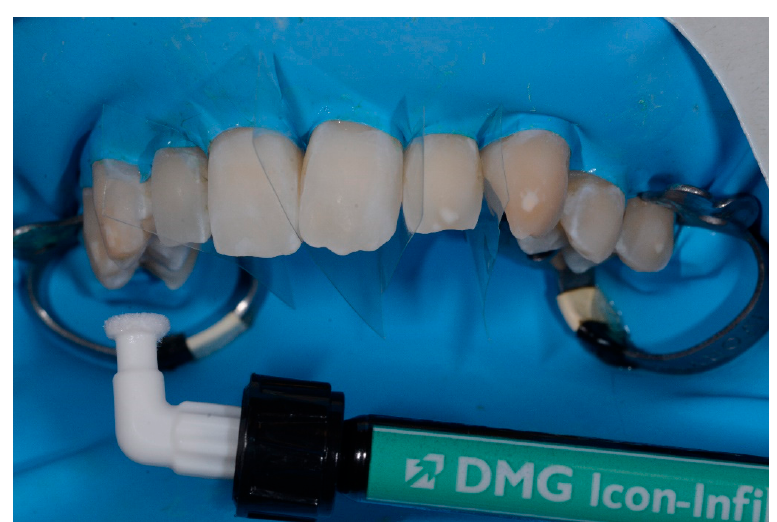
Figure 2. Application of infiltrating resin.